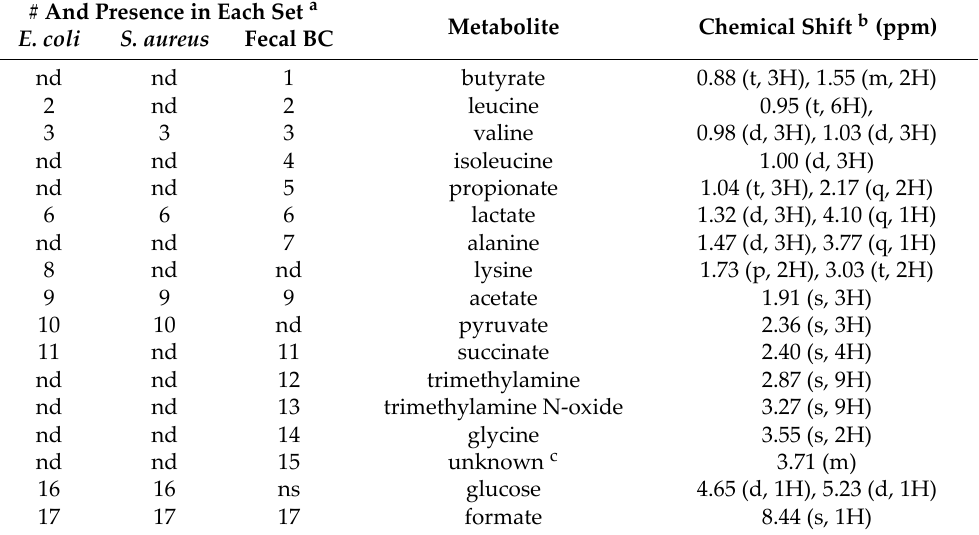
Table 1. Identified significant metabolites from the E. coli , S. aureus , and fecal BC sample sets, se‑ lected resonance 1 H chemical shifts (ppm), multiplicities, and the number of protons contributing to these